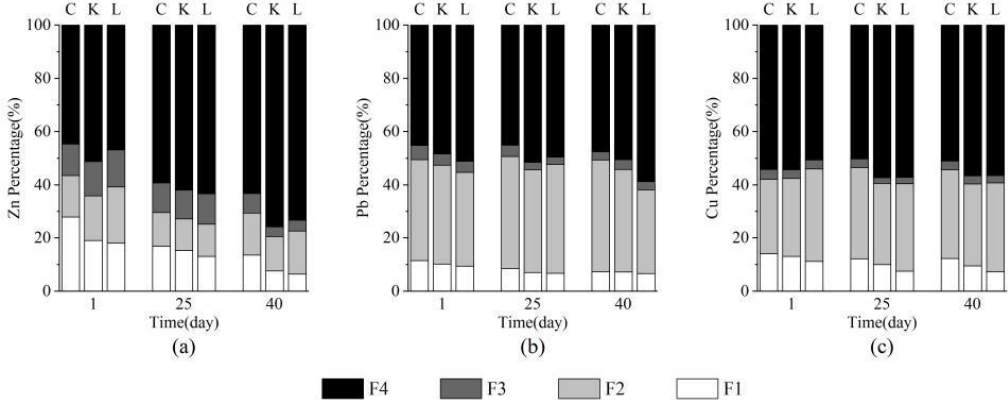
Figure 2. The distribution of the chemical fractions of metals in the sediments. C: control, K: kaolinite, and L: limestone. ( a ) The chemical fractions of Zn in control, kaolinite and limestone groups with incubation time periods of 1 day, 25 days, and 40 days; ( b ) The chemical fractions of Pb in control, kaolinite and limestone groups with incubation time periods of 1 day, 25 days, and 40 days; ( c ) The chemical fractions of Cu in control, kaolinite and limestone groups with incubation time periods of 1 day, 25 days, and 40 days.